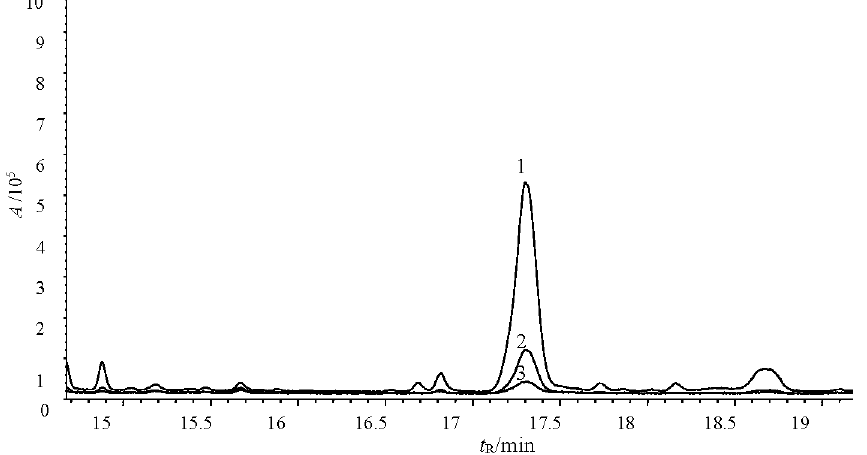
Figure 6. Ergosterol content of untreated and treated V. mali hyphal cell membranes. Peak 1: The content of ergosterol in membranes treated with 40 μ g/mL (working concentration) tobacco cembranoids extract; Peak 2: Ergosterol content following 20 μ g/mL (working concentration) treatment; Peak 3: Ergosterol content following treatment 95% ethanol (control).